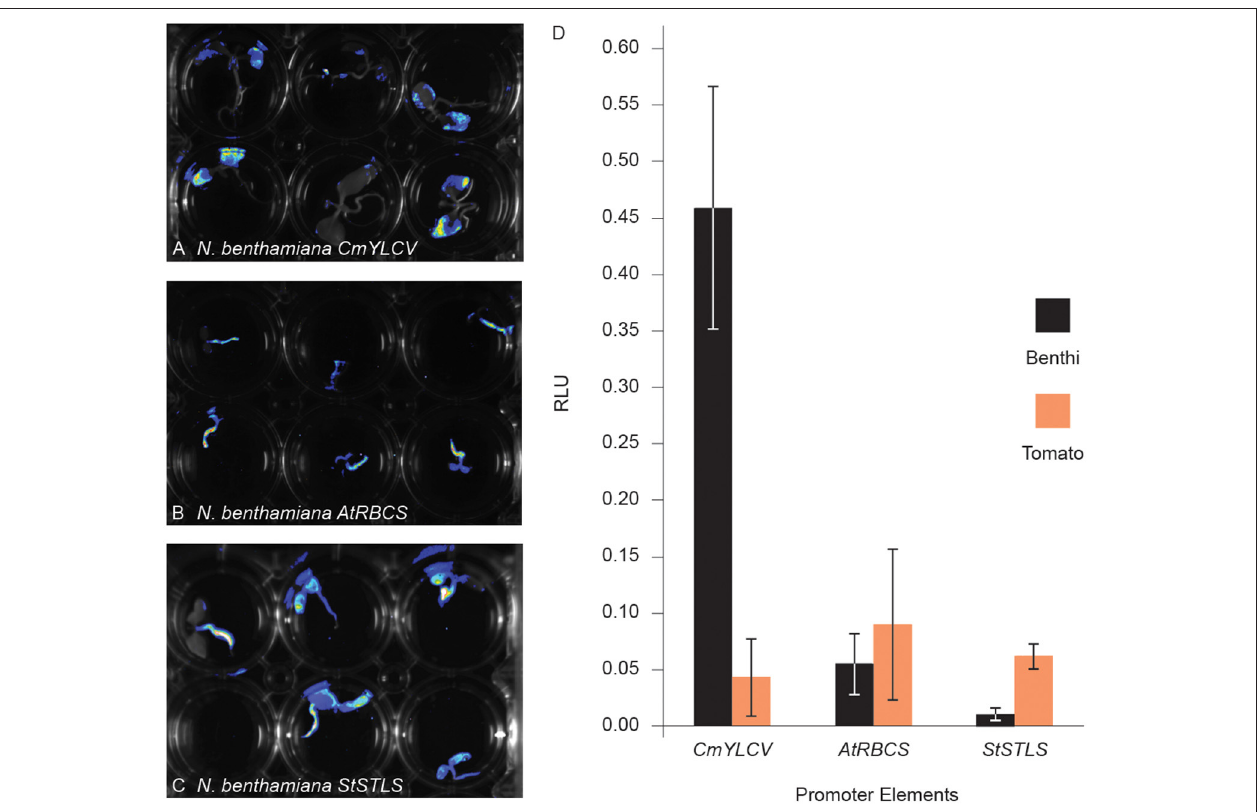
FIGURE 3 | Comparing promoter activity with fast-TrACC using a dual luciferase assay. Activity of three promoters, CmYLCV (A) , AtRbcs3B (B) , and StSTLS (C) , were compared in N. benthamiana and tomato. These promoters, driving firefly luciferase, were first delivered to N. benthamiana seedlings and qualitatively assessed for activity (A–C) . Once promoter activity was confirmed in N. benthamiana , T-DNAs with both 35S:Renilla luciferase and the test promoters driving firefly luciferase were delivered to N. benthamiana and tomato seedlings. From seedling-derived lysates, luminescence was recorded for both luciferases. Between the two luminesce values, a relative luciferase unit (RLU) was calculated for the given promoter for direct comparison (D) . CmYLCV expression was 35-fold higher in N. benthamiana when compared to tomato, demonstrating the usefulness of Fast-TrACC for quantitative measurements of promoter activity. Error bars represent ±